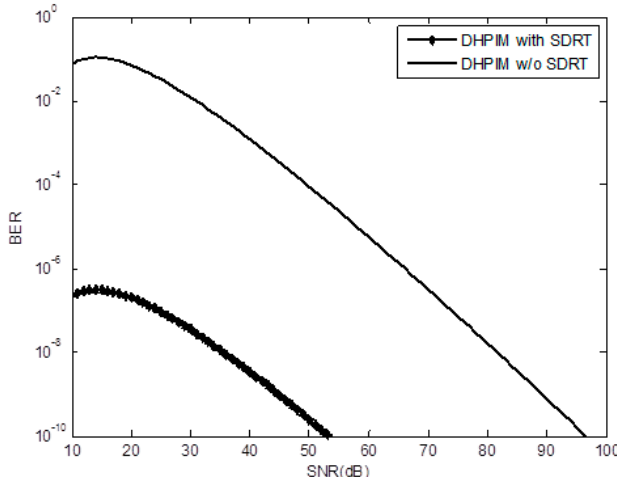
Figure 10. BER performance of dual header-pulse interval modulation (DH-PIM) with SDRT and without SDRT in a weak turbulence channel.